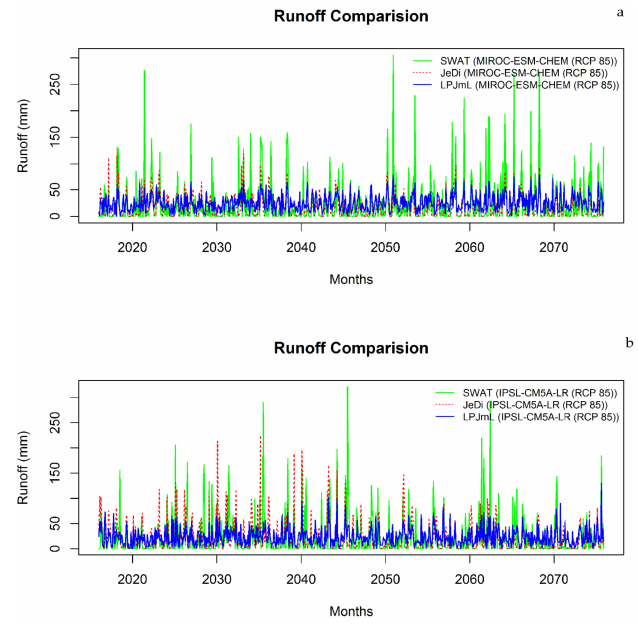
Figure 10. Runoff comparison of simulated monthly runoff from simulation forced with MIROC-ESM-CHEM ( a ) and IPSL-CM5A-LR ( b ) for RCP 8.5 climate scenarios for the SWAT, LPJmL and JeDi-DGVM